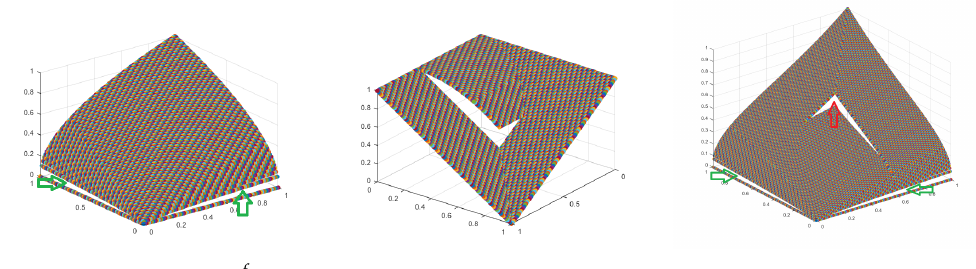
Figure 2. f , h , PQO = f